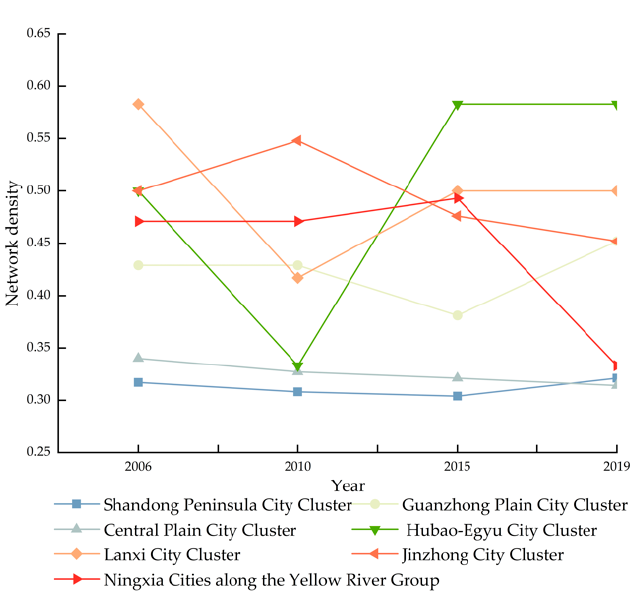
Figure 7. Net density of carbon efficiency in seven city clusters.